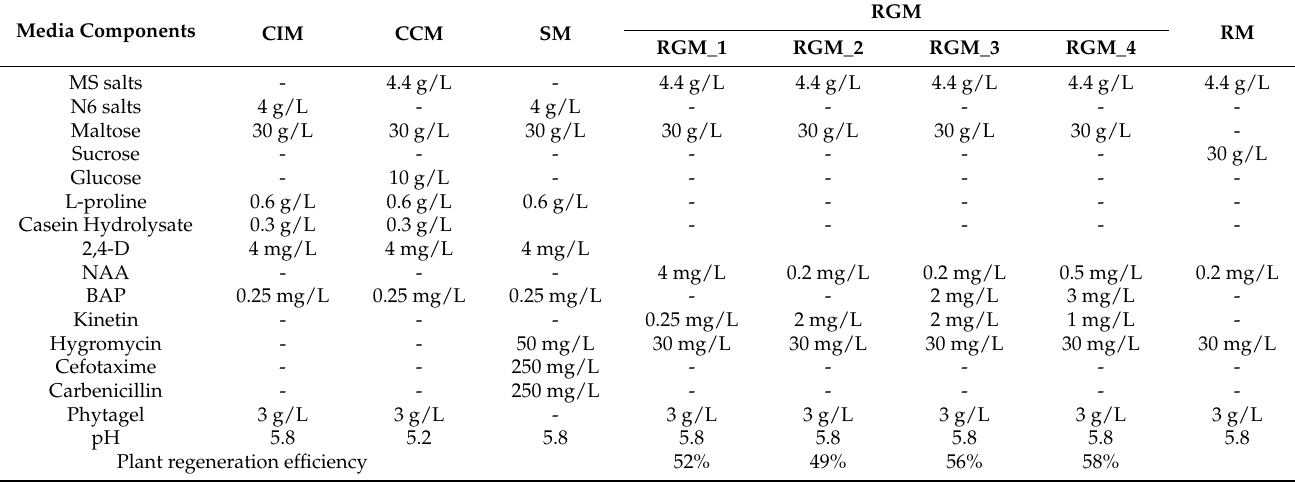
Table 1. Composition of the different media used in rice transformation, and the calculated regenera- tion